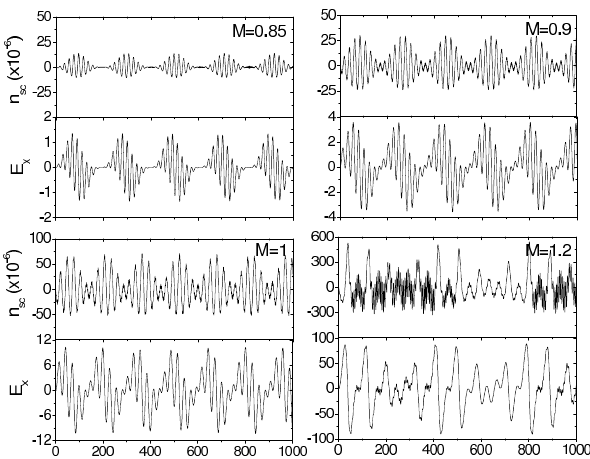
Fig. 15. Same as Fig. 13 but the impact of ξ T = T e /T i on LH- oscilliton waves. Notice that the panels of T e /T i =10 is the typical case discussed in the last section.